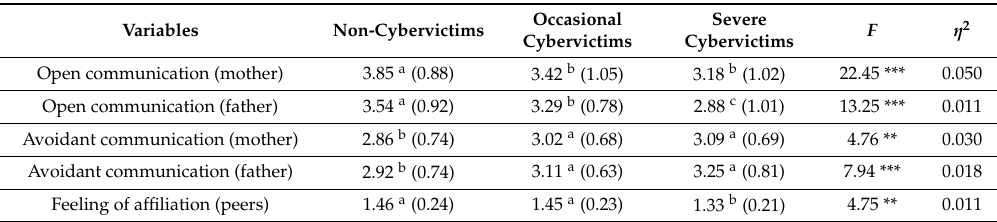
Table 3. Mean (Standard Deviation), ANOVA of differences between cybervictim groups in variables family communication and feeling of